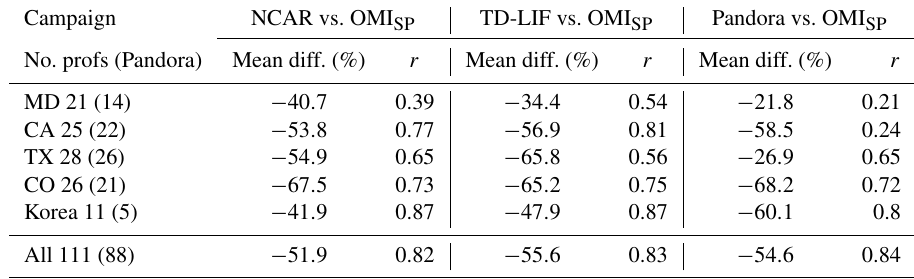
Table A2. Summary of NO 2 comparison between the OMI Standard Product (OMI SP ) and NCAR, TD-LIF, and Pandora observations. The mean difference is calculated as OMI minus observations.